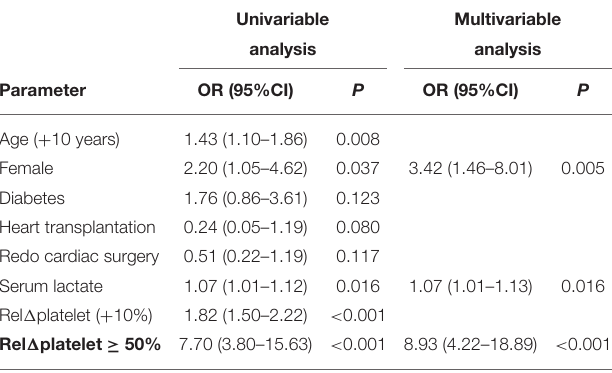
TABLE 3 | Logistic regression analyses for in-hospital mortality. Univariable Multivariable analysis